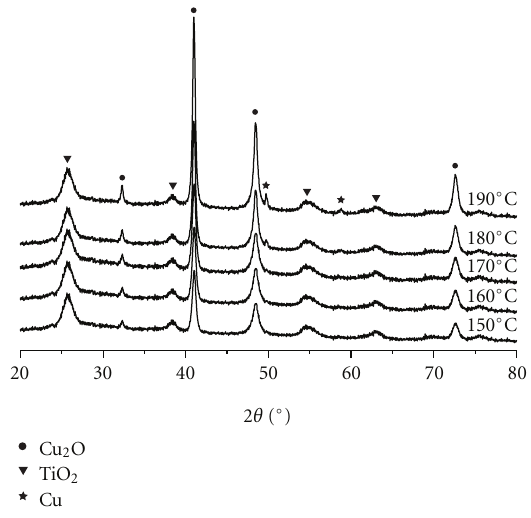
Figure 1: XRD patterns of the Cu 2 O-TiO 2